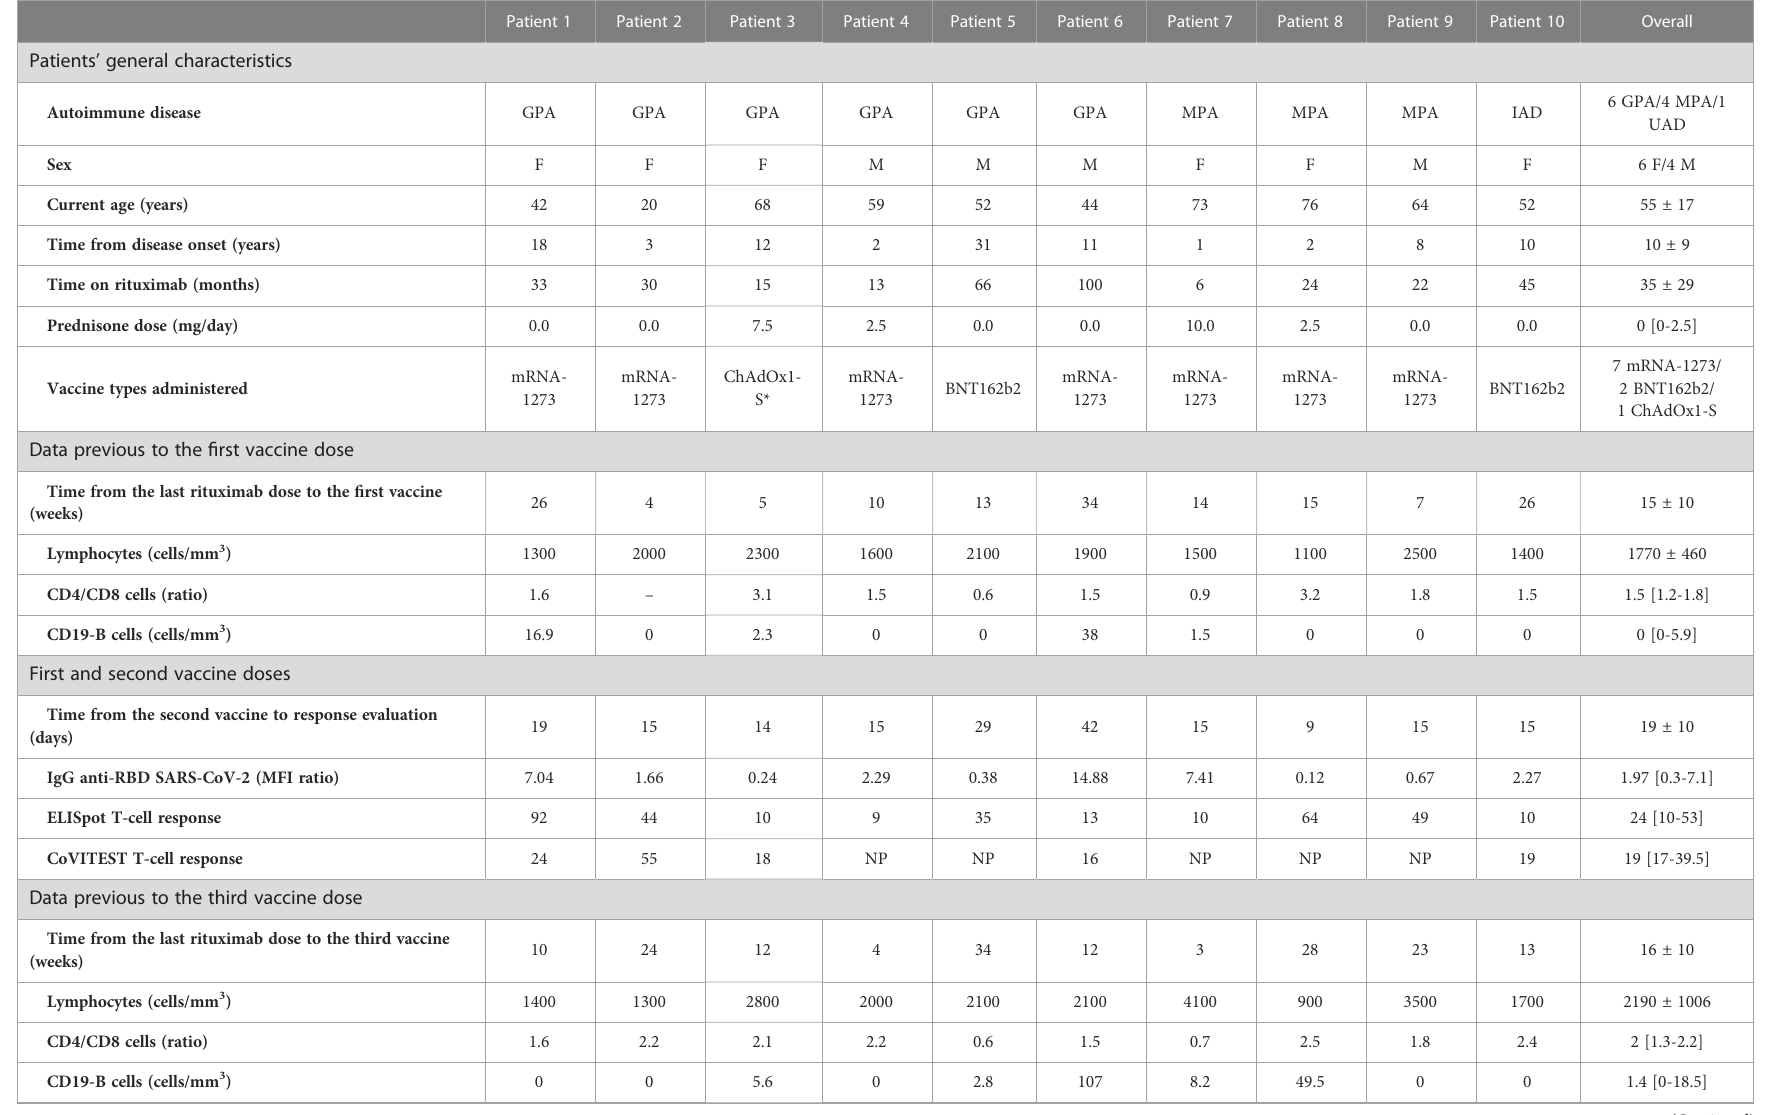
TABLE 1 Clinical characteristics, lymphocyte cell populations, and humoral and cellular responses to SARS-CoV-2 vaccines of patients with autoimmune diseases treated with rituximab in the present